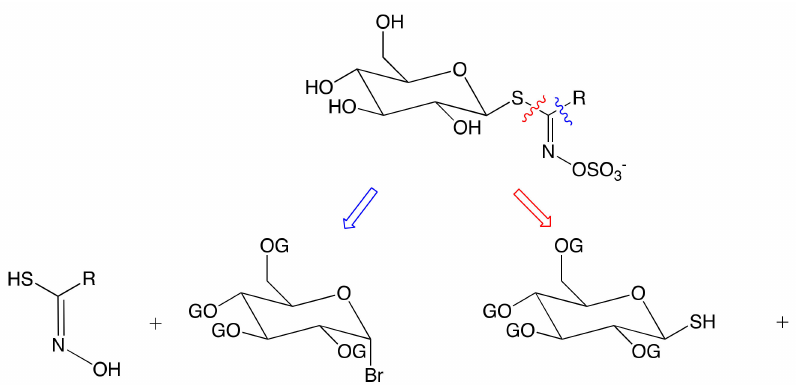
Figure 4. Retrosynthesis approach to GSL synthesis: anomeric disconnection (blue), hydroximate disconnection (red). OG: suitable protecting group.